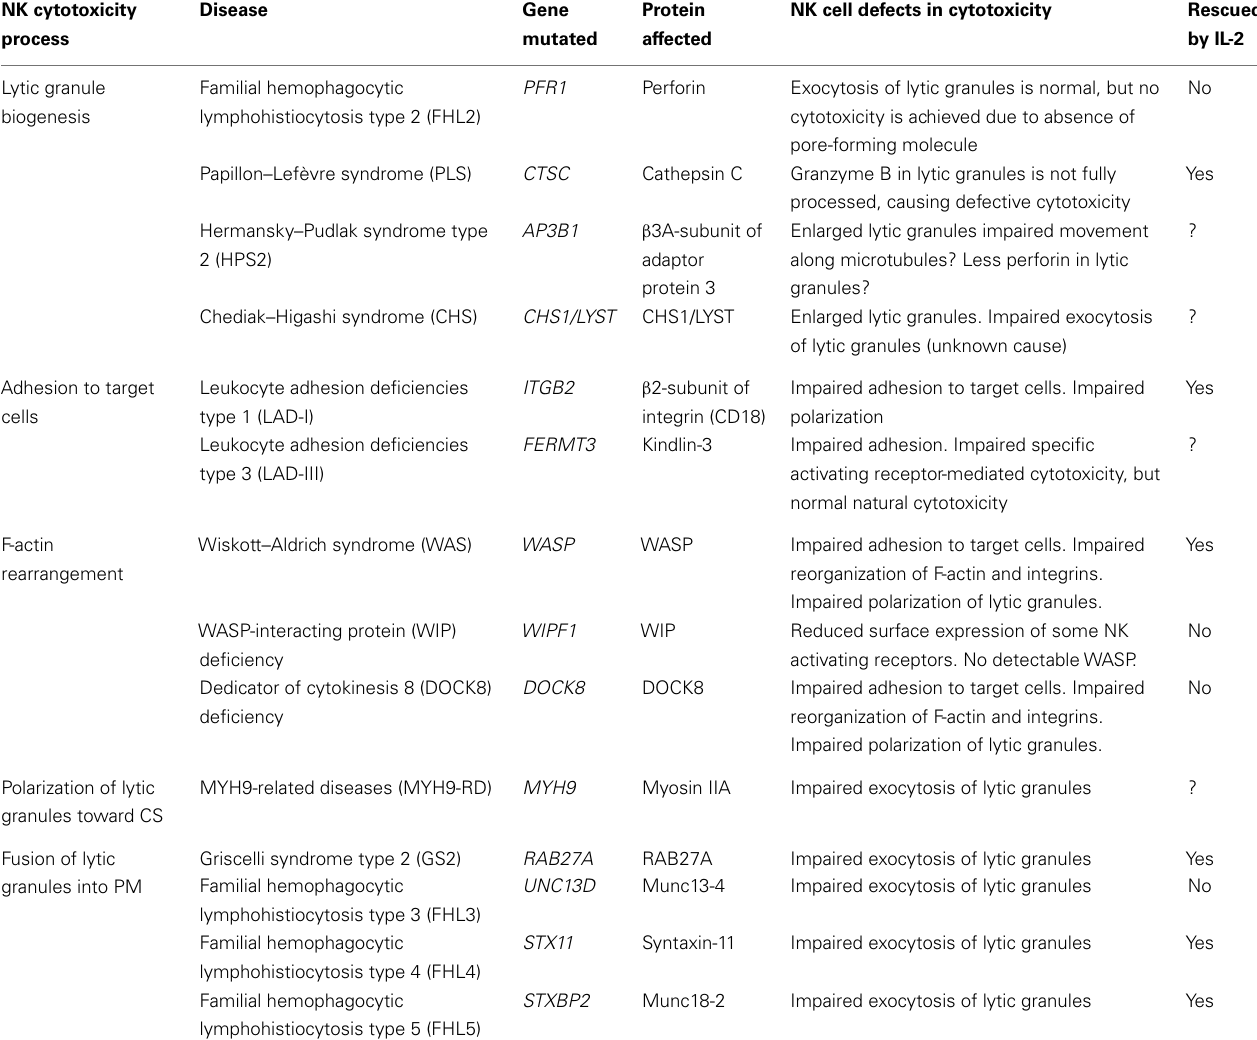
Table 1 | Human primary immunodeficiency syndromes with defective NK cell cytotoxicity